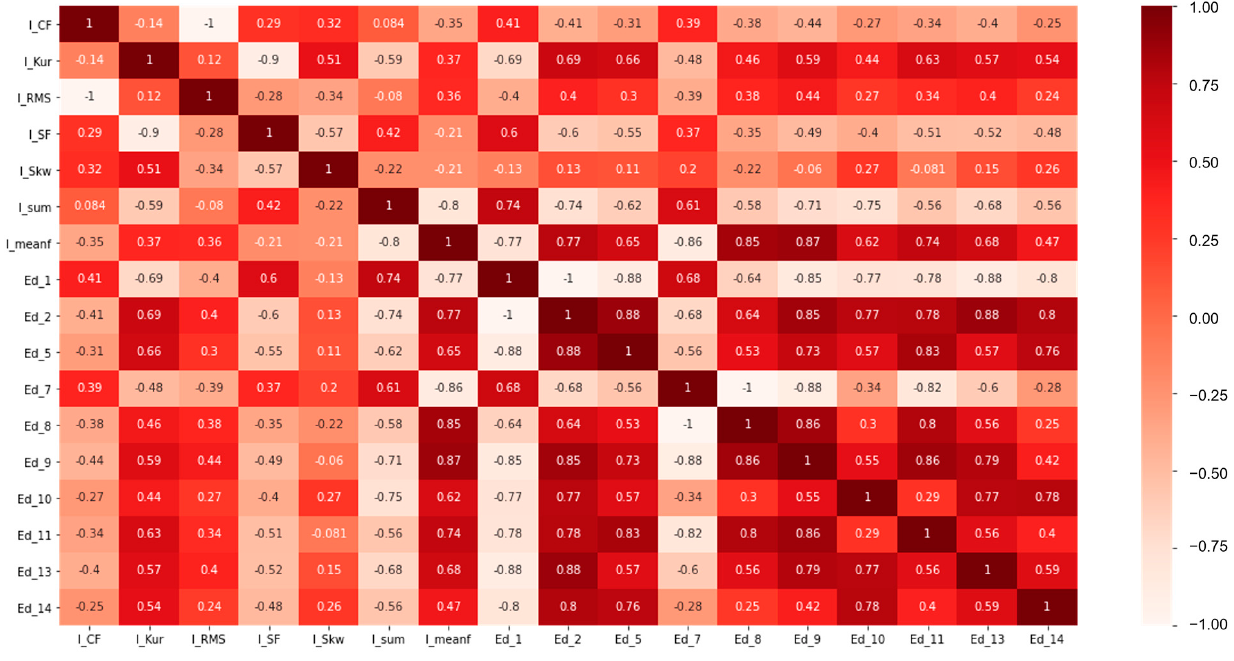
Figure 12. The correlation coefficients between all 27 features.